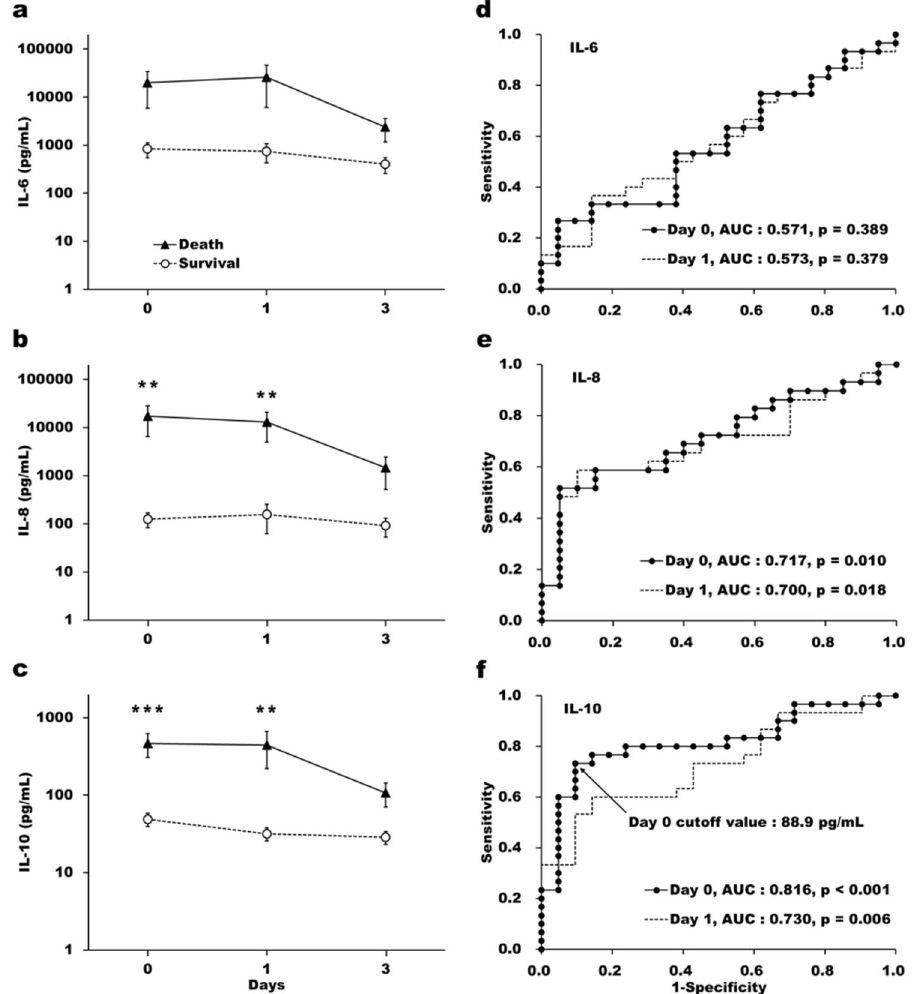
Figure 1. Initial plasma interleukin-10 level was a better prognostic biomarker than interleukins 6 and 8 in ARDS patients receiving ECMO support. Plasma interleukin-6 ( a ), interleukin-8 ( b ), interleukin-10 ( c ) concentrations were assessed in survivors (n = 21, open circles ) and non-survivors (n = 30, solid triangles ) at 0, 1, and 3 days after receiving ECMO support. Receiver-operating characteristic (ROC) analysis showed dissimilar predictive capabilities among initial cytokine values for ICU mortality. ( d ) Interleukin-6 levels at neither day 0 nor day 1 after ECMO support could differentiate the survivors from the non-survivors. Both Interleukin-8 ( e ) and interleukin-10 ( f ) predicted the outcome well by analysis using the ROC curve at day 0 and 1. However, the best predictive ability was tested in interleukin-10 level at day 0, with the optimal cutoff value at 88.9 pg/mL. The data represented the means and standard errors of each group. Values were logarithmically transformed before bivariate comparisons. ** , and *** stand for P < 0.01, and P < 0.001, respectively, between death and survival